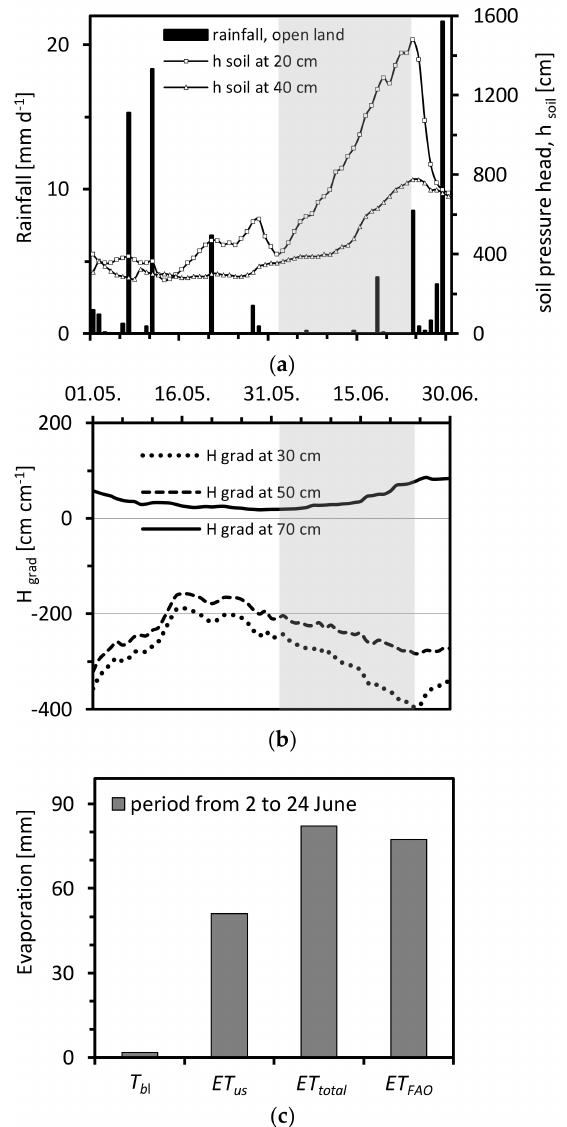
Figure 2. ( a ) Daily rainfall and daily averages of the soil pressure head at the depths of 20 and 40 cm of black locust (upper) and ( b ) soil hydraulic gradients (middle) for the period from 1 May to 30 June 2012 as well as ( c ) sums of tree transpiration ( T bl ), understory evapotranspiration ( ET us ), total evapotranspiration ( ET total ), and FAO grass reference evapotranspiration for the period from 2 to 24 June 2012